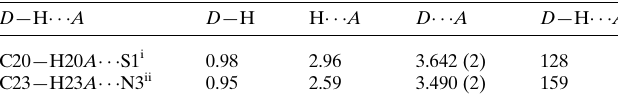
Table 1 Hydrogen-bond geometry (A˚ , (cid:4) ).